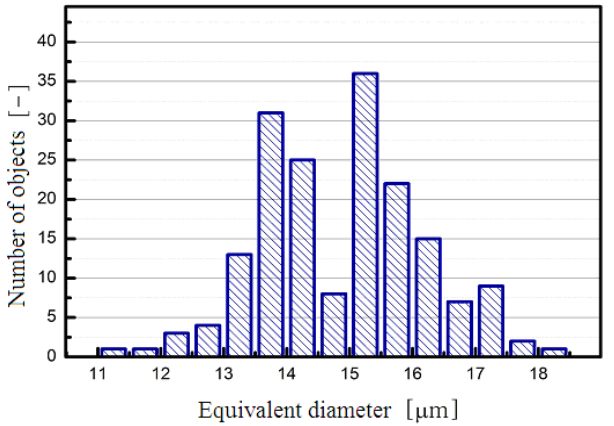
Figure 16. Size distribution of glass fiber diameters in the GRE material for the HVAC composite insulator carrying rod.